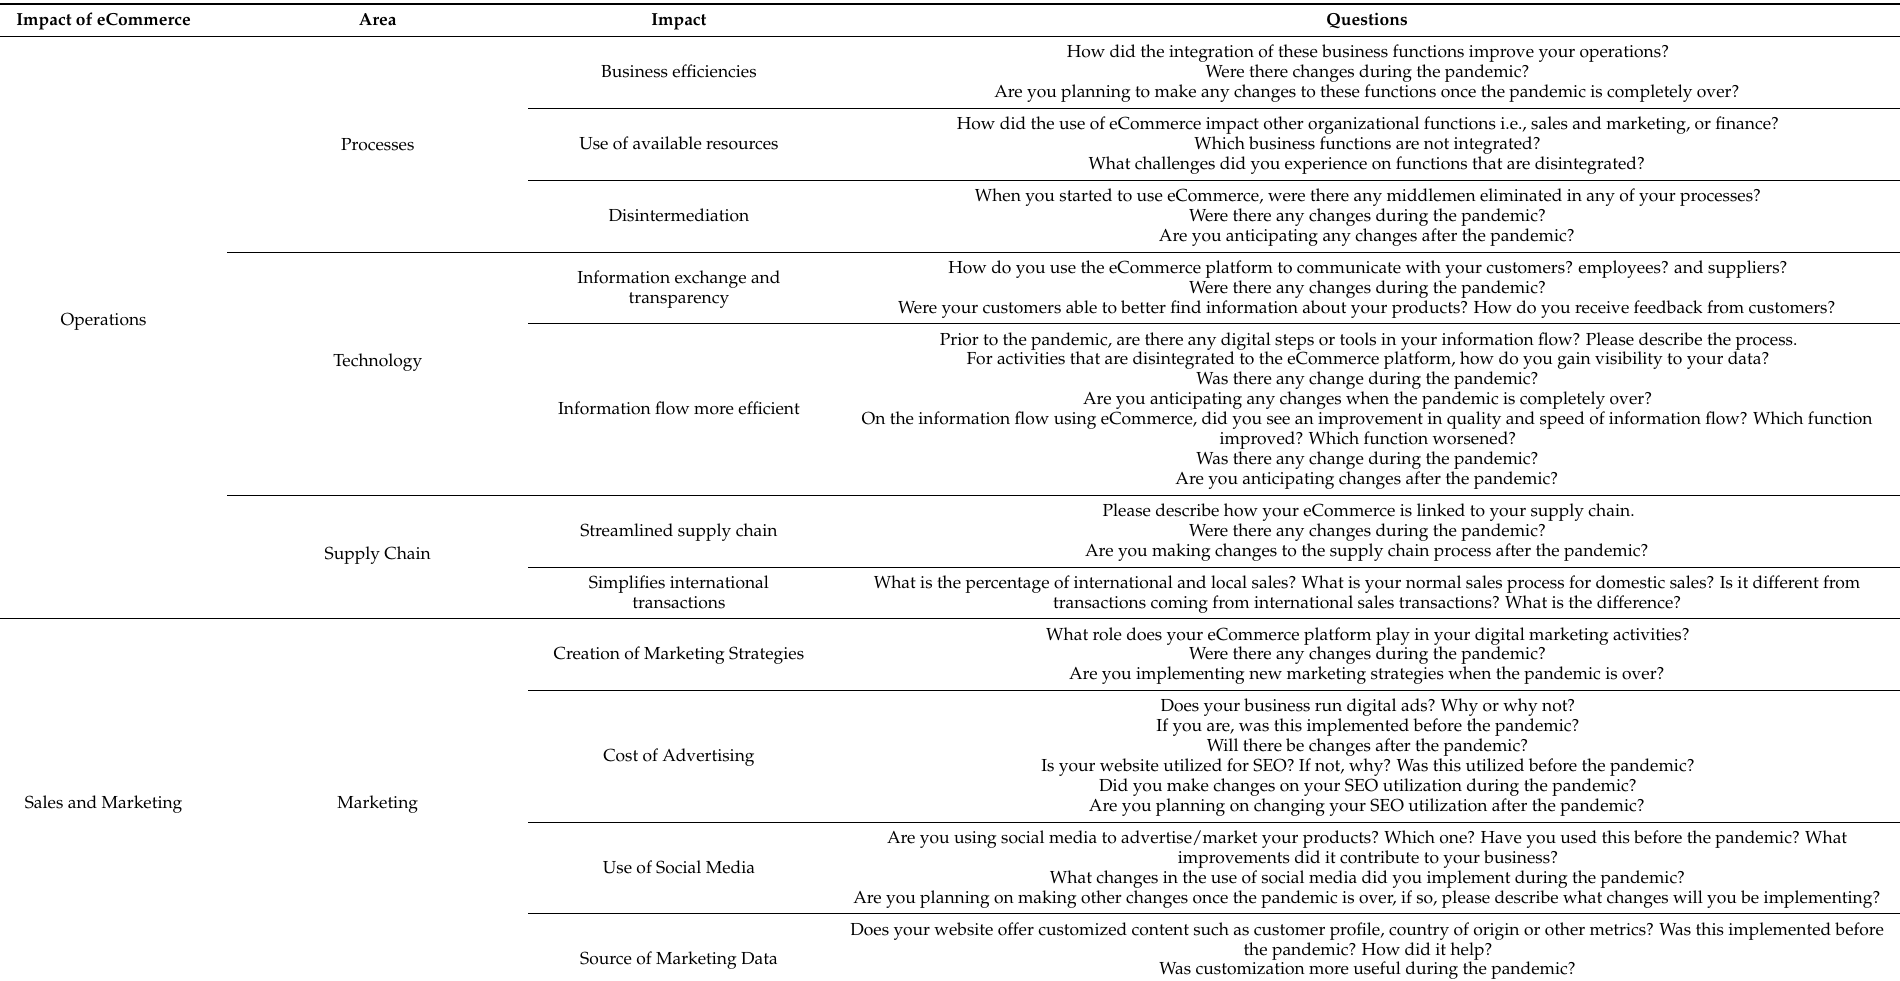
Table A2. Semi-structured Interview Questions per Impact of eCommerce to an